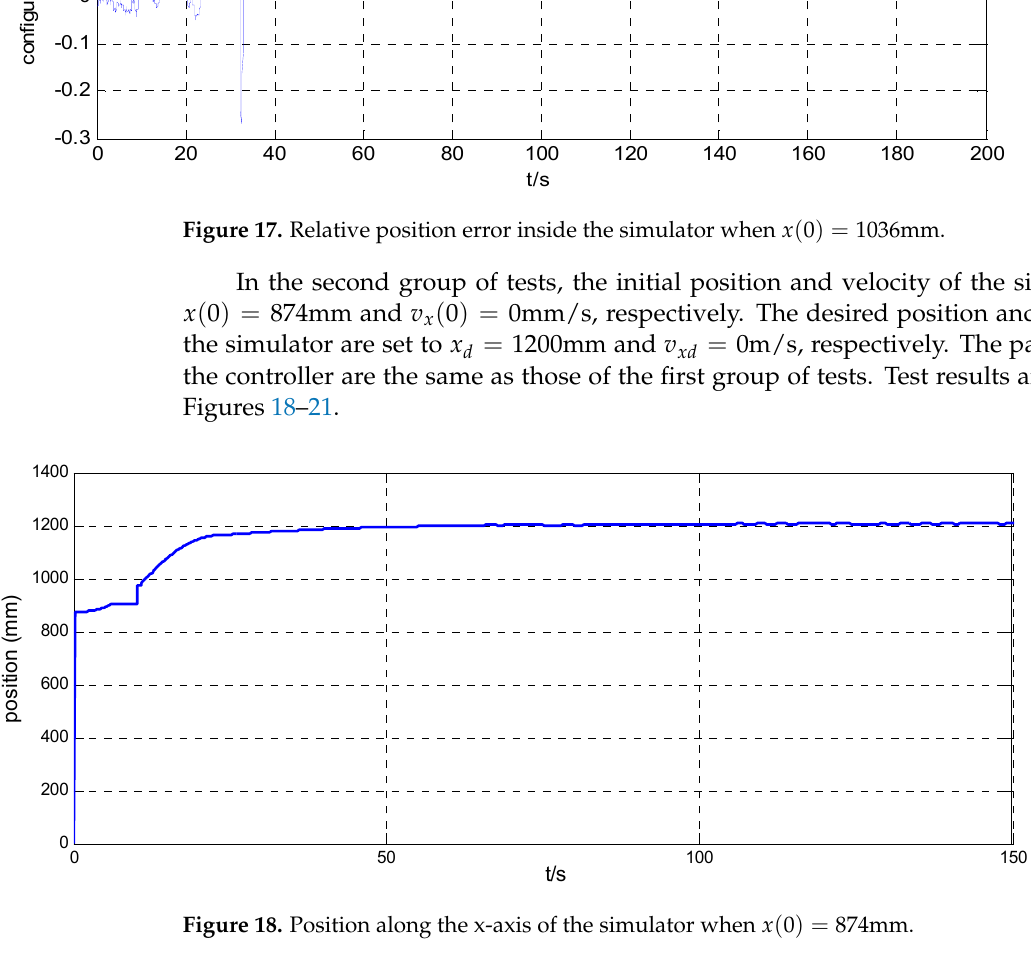
Figure 18. Position along the x-axis of the simulator when